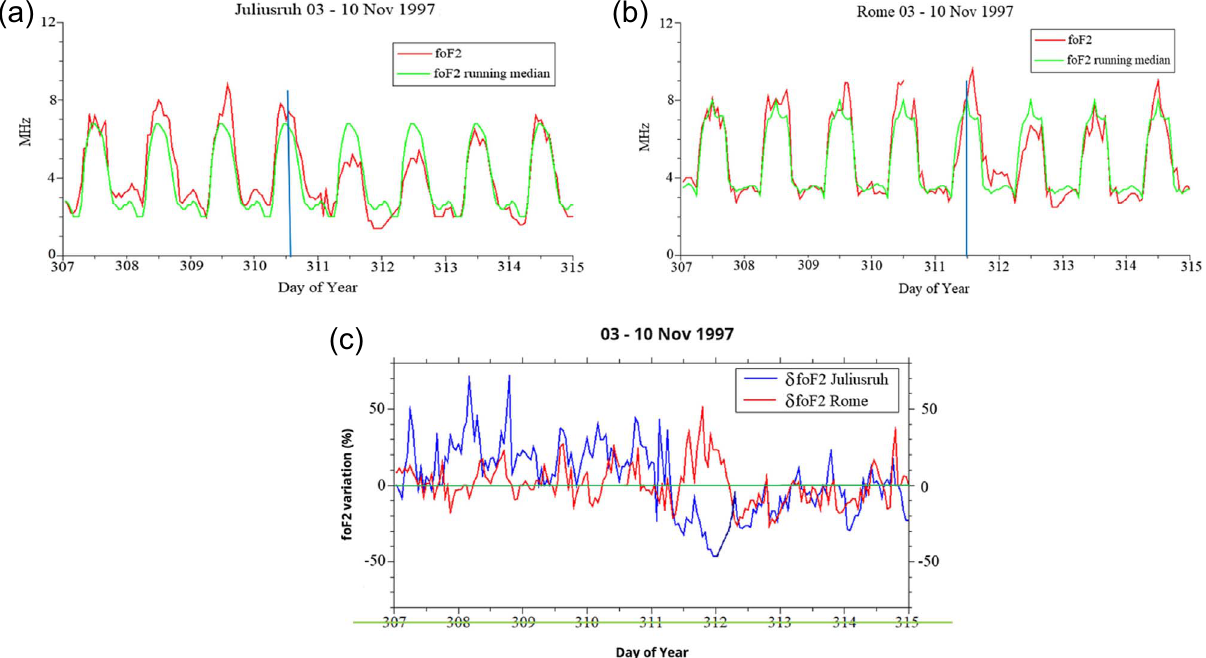
Fig. 7. In panel (a), the red line represents the hourly values of foF2, recorded at Juliusruh ionospheric station from 03 to 10 November 1997. The green line represents the foF2 running median here considered as background value of the ionospheric parameter. In panel (b) the same parameters, recorded by the Rome ionospheric station, are reported, considering the same time period. In panel (c) is reported the variation in percentage of the foF2 for the two ionospheric stations, for the considered